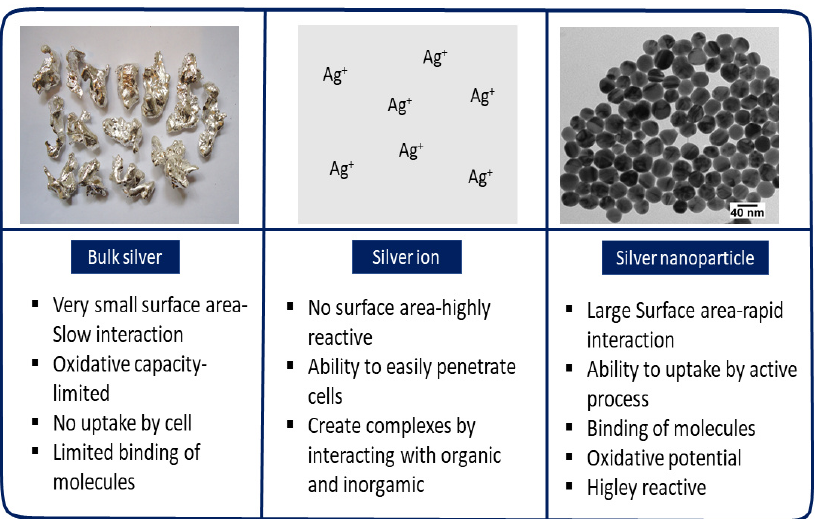
Figure 1. The fundamental variations between the characteristics of silver in ionic, nanoparticulate, and bulk forms.